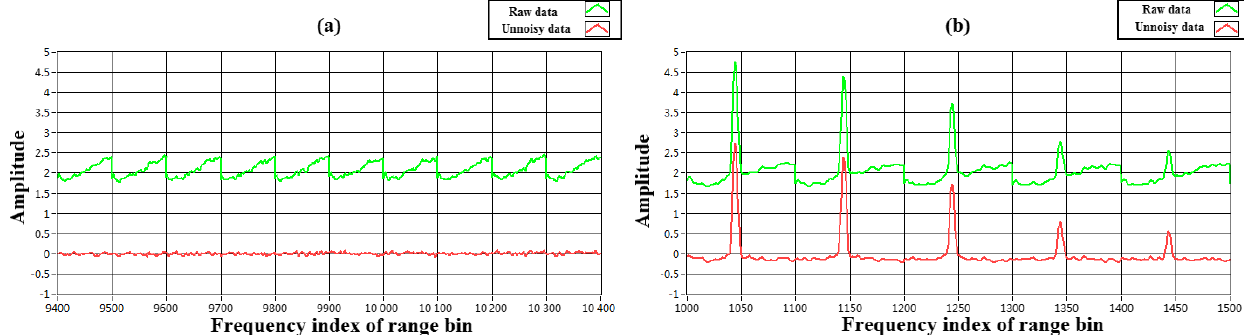
Figure 3. The CDL measured array of the FFT spectra, (a) the last 10 range gates spectra for background noise spectrum estimation, and (b) the 1st–5th range gates (150–270m, range resolution is 30m) spectrum.